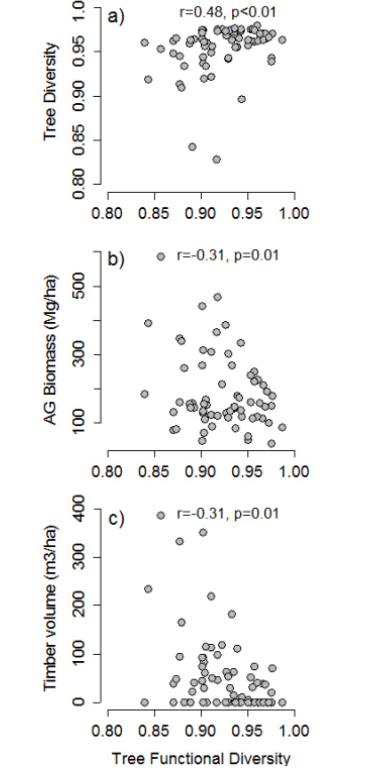
Fig. 3 . Biplots of forest value components defining major axes of variation across the 69 sampled plots in southwestern Amazonia. Functional Diversity (Rao’s Q) vs (a) Taxonomic Diversity (Simpson), (b) aboveground biomass, and (c) harvestable volume of commercial timber